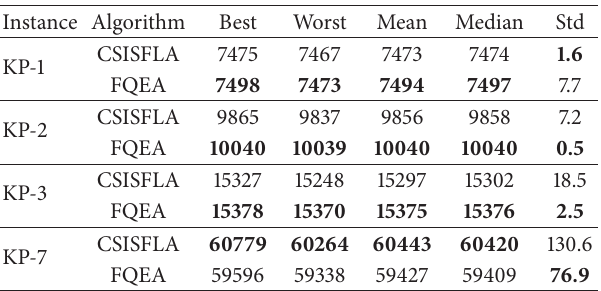
Table 8: Comparative study between CSISFLA and FQEA on 0-1 knapsack problems with the number of items being